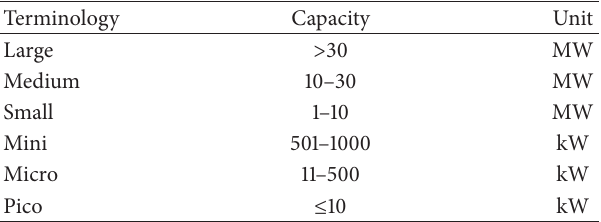
Table 1: Hydropower classification in Ethiopia